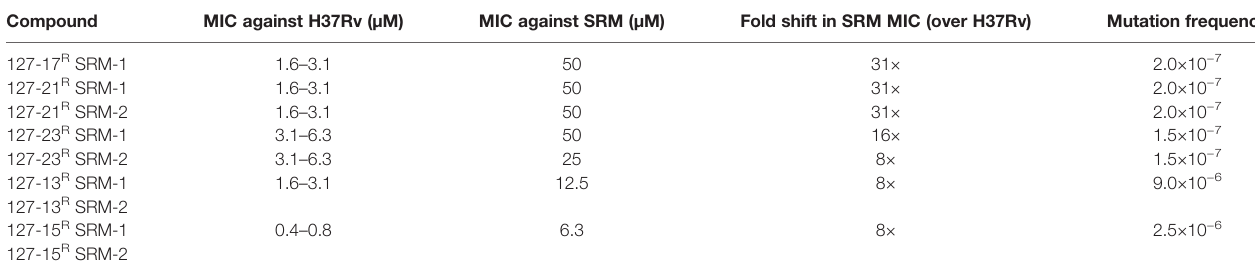
MICs in 7H9 OADC media.